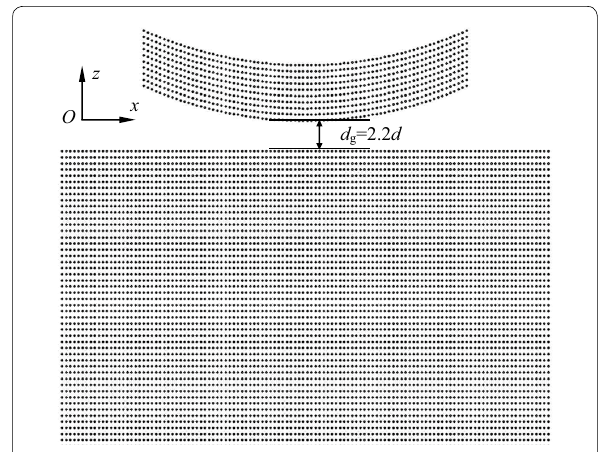
Figure 7 Three‑dimensional nanoscale sliding contact model between a rigid cylindrical tip and an elastic substrate